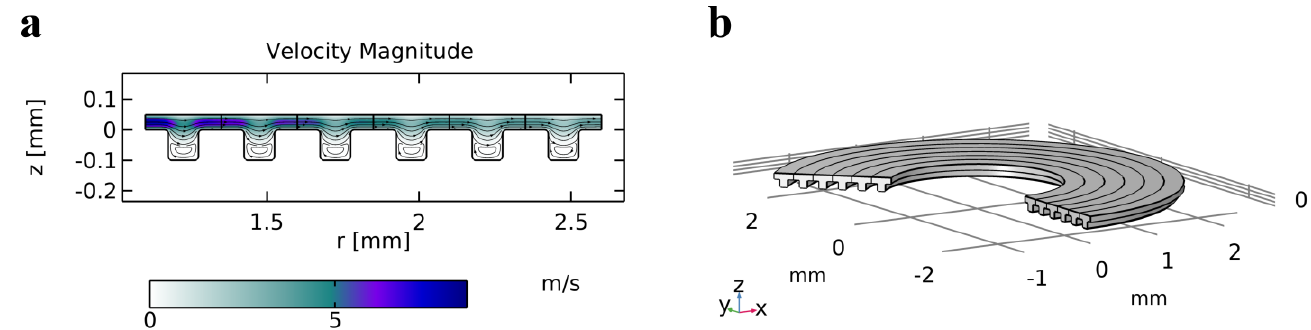
Figure 3. Simulation model used to evaluate the impact of concentric, ring-shaped trenches on the fluidic resistance of the valve seat. ( a ) Cross-sectional view of the two-dimensional simulation domain. ( b ) Section of the axisymmetric model. The arrows visualize the fluid flow from the inner to the outer boundary, as well as the vortices developing in the trench.